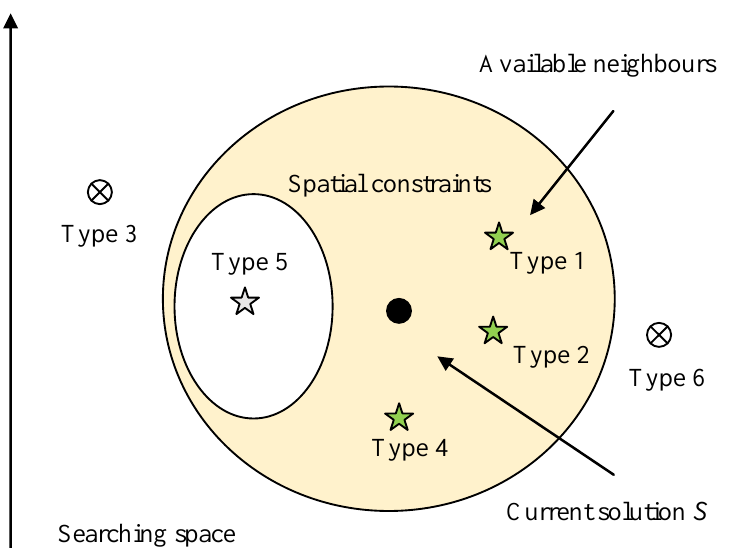
Figure 4. Selection of the acceptable candidate